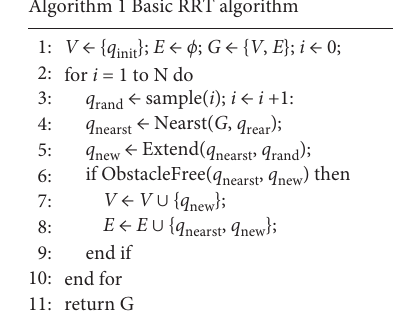
Figure 3: Basic RRT algorithm.